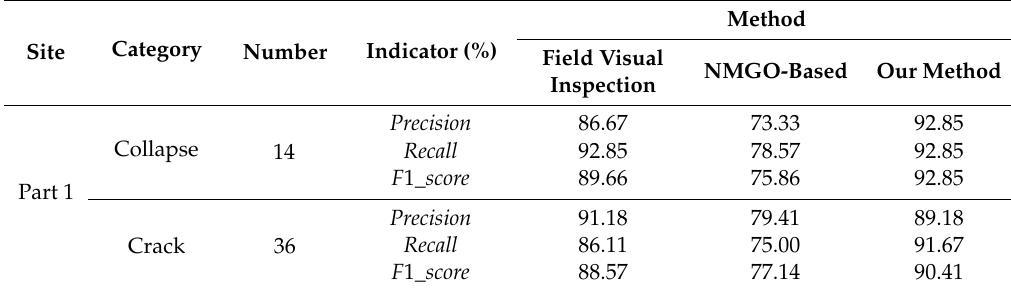
Table 3. Comparison of the three indicators obtained through field visual inspection, NMGO-based method, and our